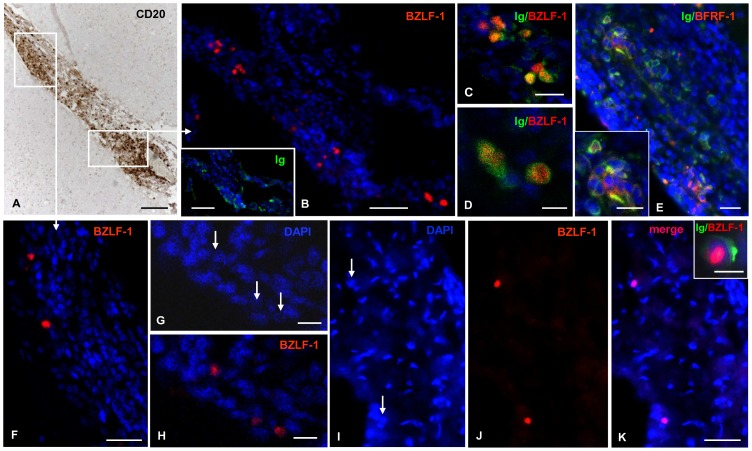
Immunohistochemical detection of BZLF-1 in the inflamed meninges of the MS brain.(A) A prominent immune infiltrate comprising a perivascular B-cell-follicle-like structure is visualized with anti-CD20 antibody in the meninges lining a cerebral sulcus of a MS case. (B) Immunostaining for the EBV immediate early lytic protein BZLF-1 in a serial section reveals the presence of several BZLF-1+ cells at the periphery of the B-cell follicle. Ig+ cells are present in the same area (inset). (C, D) High magnification pictures of Ig+ plasmablasts/plasma cells (green) coexpressing BZLF1 (red); these groups of cells correspond to those shown in the top left and bottom right parts of panel B. (E) Expression of the EBV early lytic protein BRFR1 (red) in a substantial proportion of Ig+ (red) plasmablasts/plasma cells in the same area shown in panel B; double immunofluorescence staining for Ig and BFRF-1 was performed in a section adjacent to those stained in A and B. (F) Two BZLF-1+ cells in another part of the B-cell-rich infiltrate shown in panel A. Nuclei were stained with DAPI (blue) in panels B-F. (G-K) Other examples of BZLF-1+ cells at the border of a meningeal B-cell follicle (G, H) and in a diffuse meningeal infiltrate (I-K) from a different MS case. Arrows in G and I point to the nuclei that are immunoreactive for BZLF-1 in H and J, respectively. The inset in panel K shows an Ig+ cell (green) with a BZLF-1+ nucleus (red) at high magnification. Bars = 100 µm in A and inset in B; 50 µm in B; 20 µm in C, E, F, K and inset in E; 10 µm in D, G, H and inset in K.